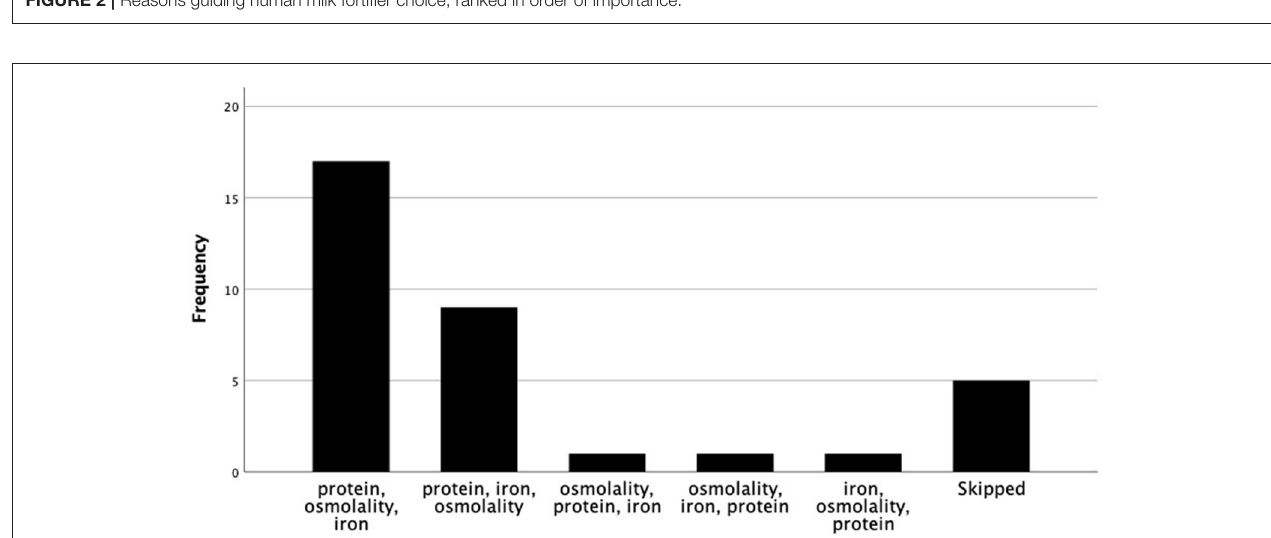
FIGURE 3 | Nutritional factors ranked in order of importance, when nutrition composition guides fortifier